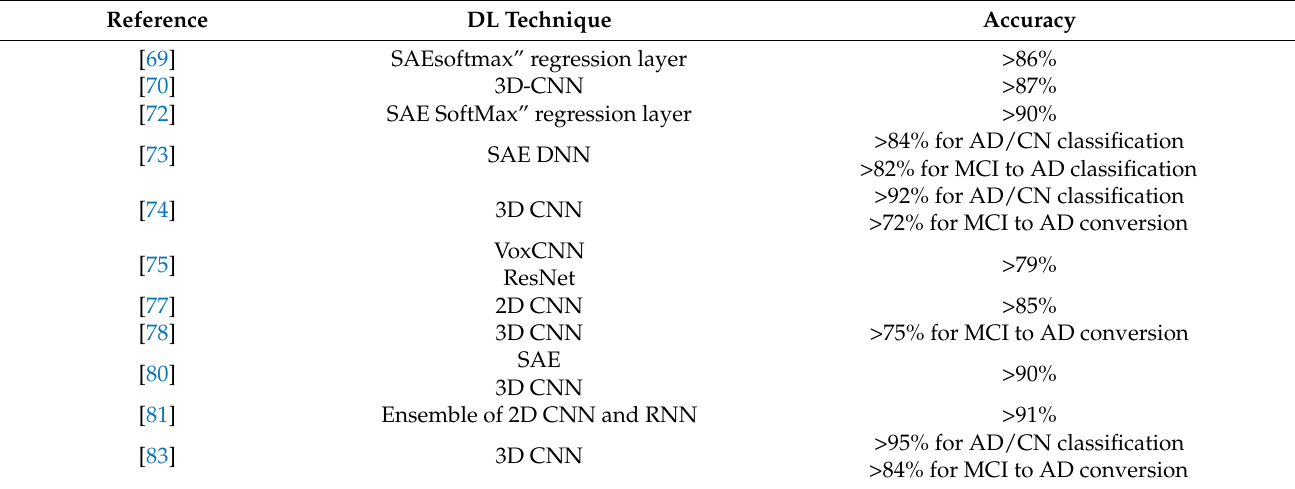
Table 1. DL techniques for feature selection on neuroimaging